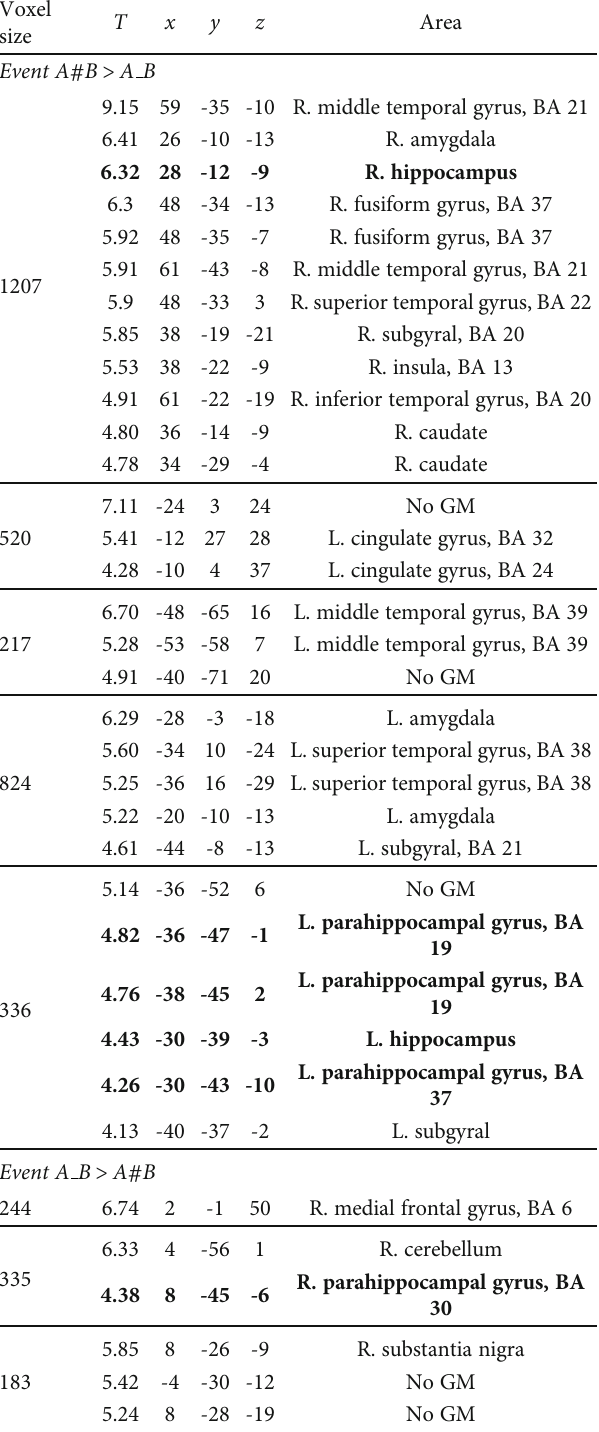
Table 4: Activities shown in the contrast of “ Event A#B > A B ” and “ Event A B > A#B ” .